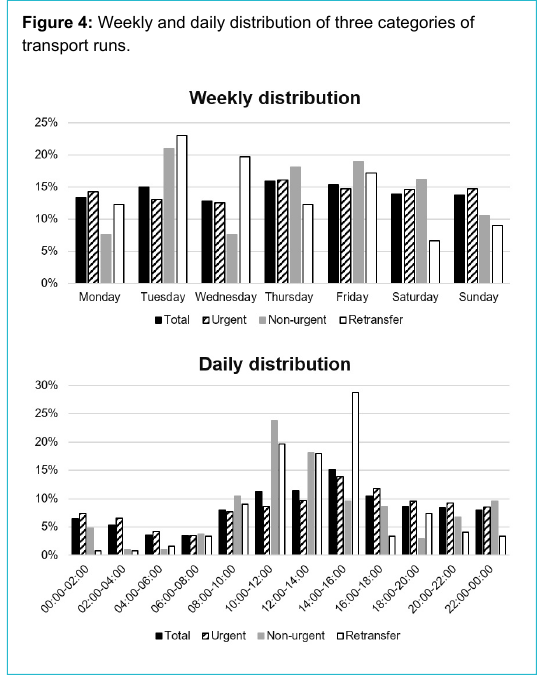
Figure 4: Weekly and daily distribution of three categories of transport